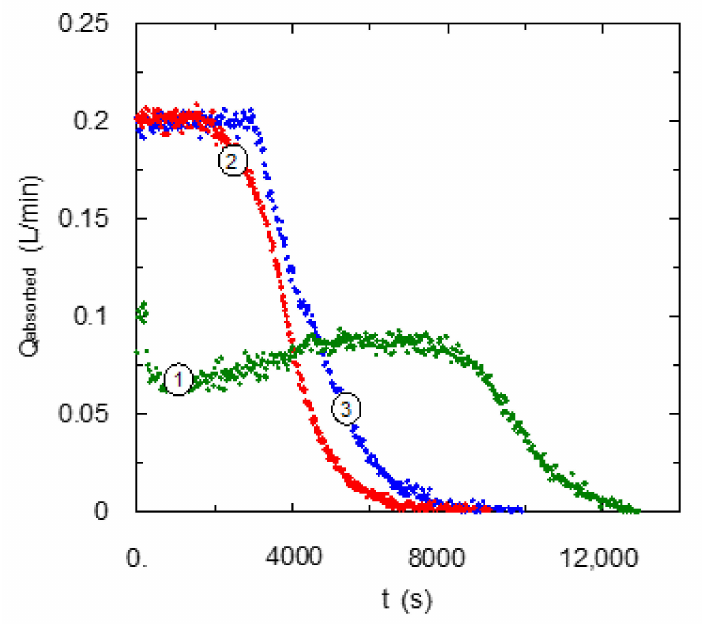
Figure 4. Effect of type of center of amino centers upon carbon dioxide absorption